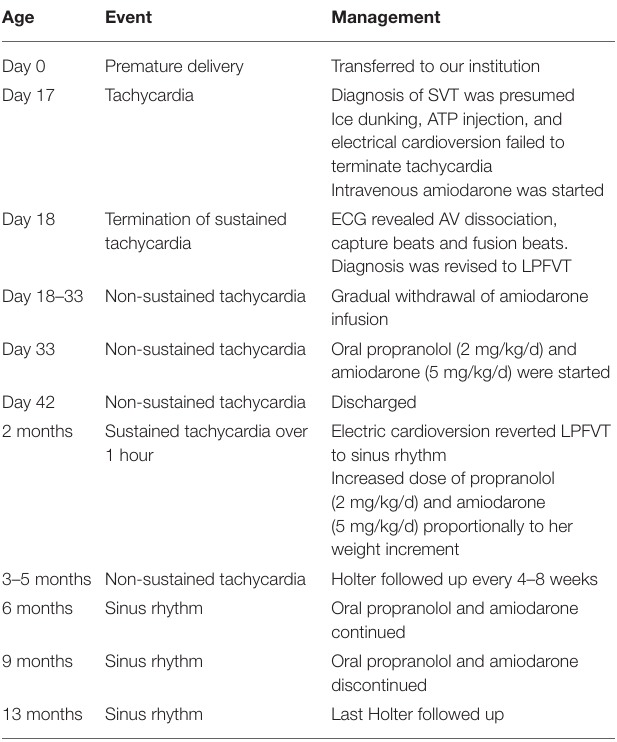
TABLE 1 | The timeline of patient diagnosis and